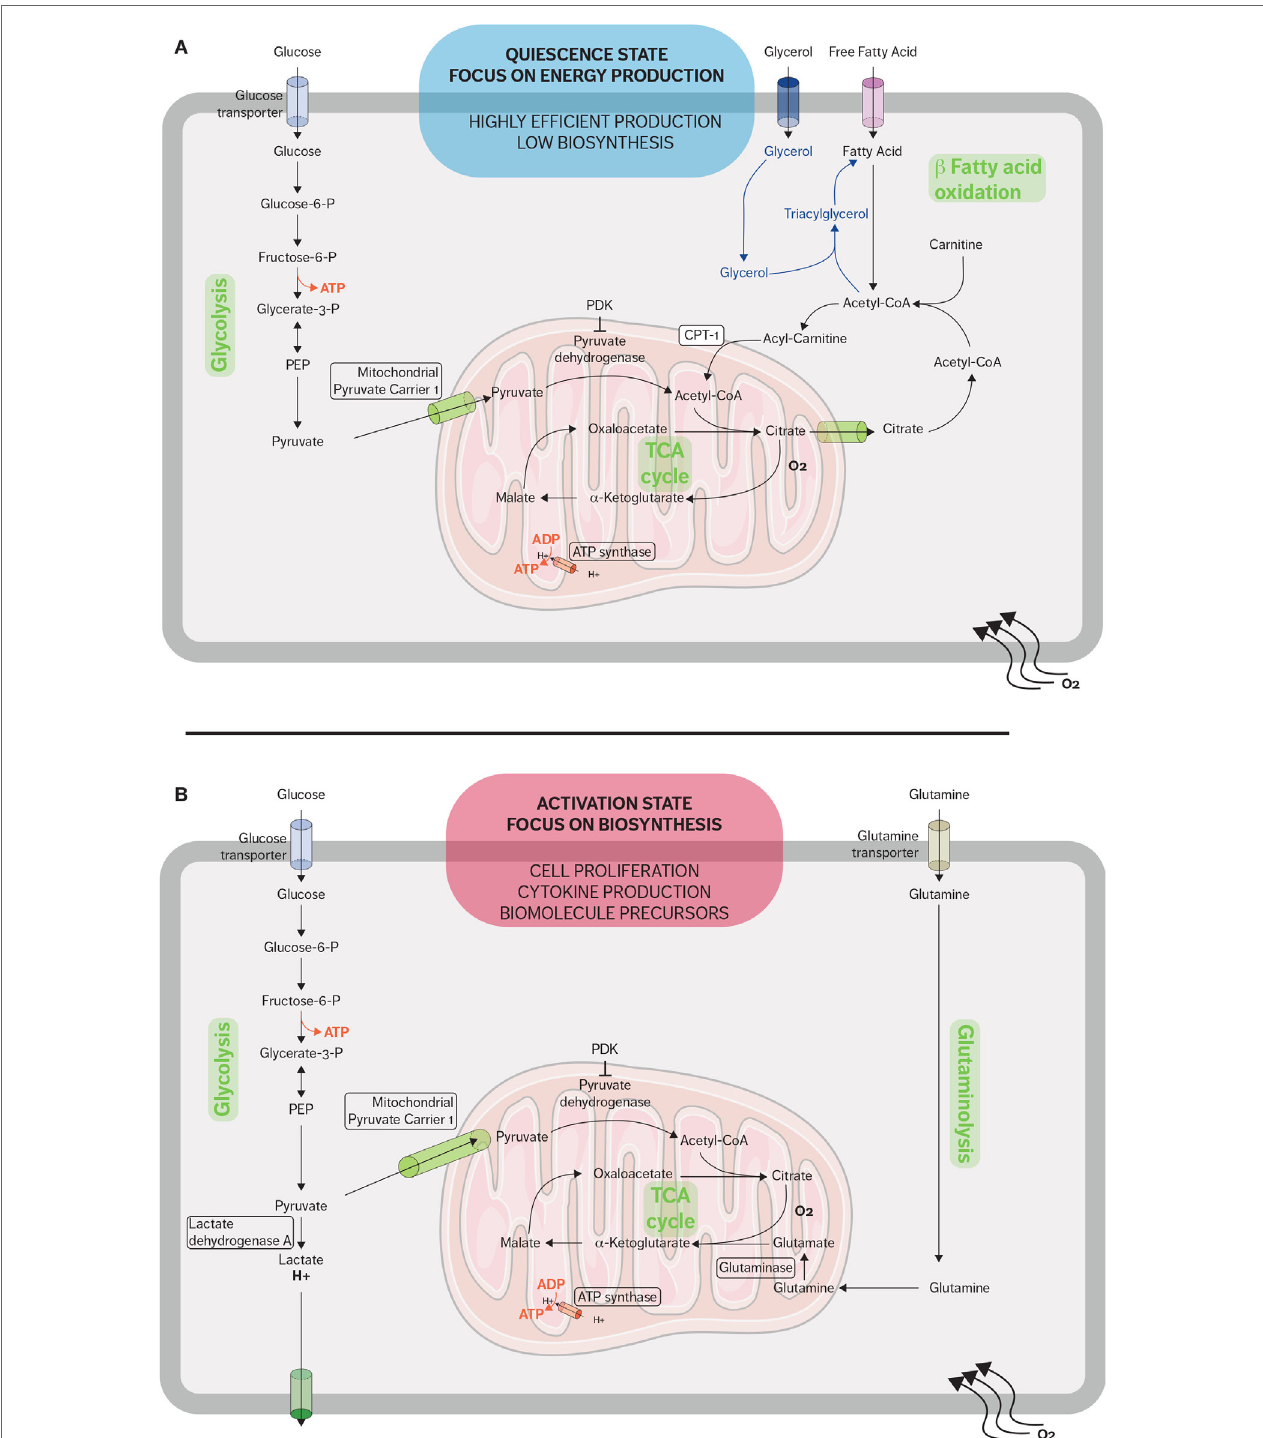
FiGURe 1 | Metabolic pathways used by CD8 T cells in quiescent and active states . (A) When in a quiescent state, naive CD8 T cells fulfill their energy needs mainly through aerobic glycolysis and mitochondrial respiration. Fatty acid oxidation plays an important role during the restriction phase when effector CD8 cells differentiate into memory CD8 cells and the immune system returns to a quiescent state. Memory T cells synthesized fatty triacylglycerols to supply fatty acids for fatty acid oxidation. (B) When stimulated, effector CD8 T cells rapidly upregulate glycolysis and glutaminolysis because the activated cells require many of the metabolic intermediates for macromolecule biosynthesis. The metabolic adaptations sustain the rapid expansion of effector CD8 T cells and support the secretion of cytokines and cytotoxic